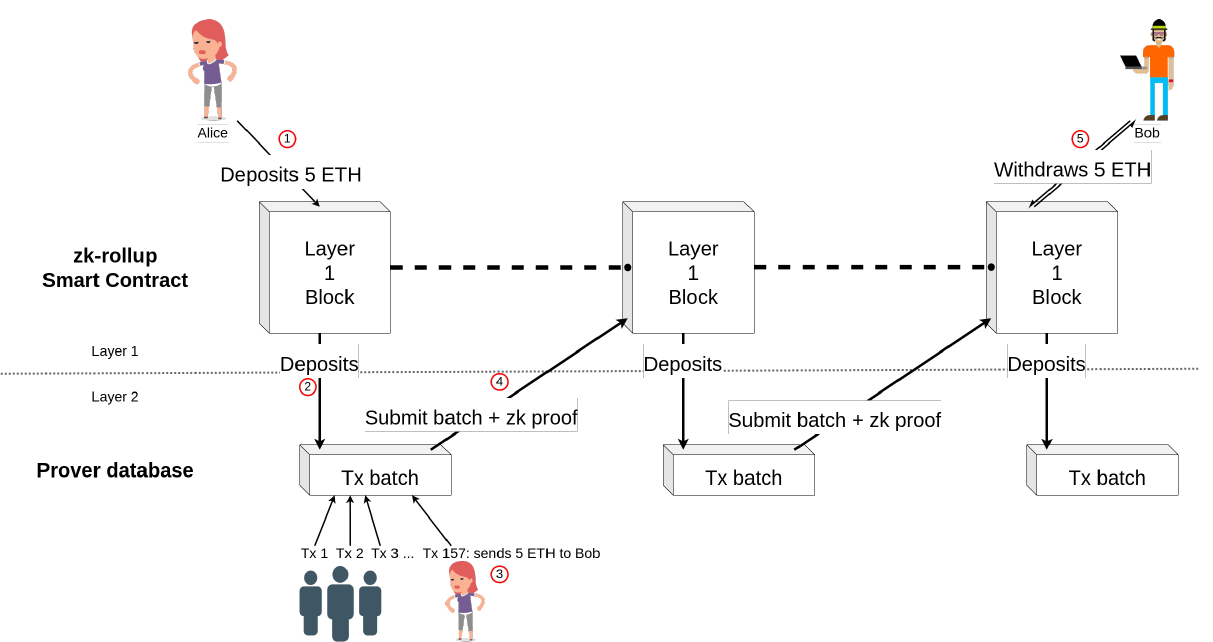
Figure 4. A transaction’s life cycle on a zk-rollup. Tx batch refers to a batch of